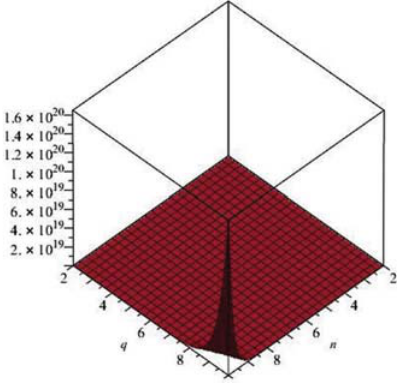
Figure 5: Plot of ξ d . Figure 8: Plot of ABC